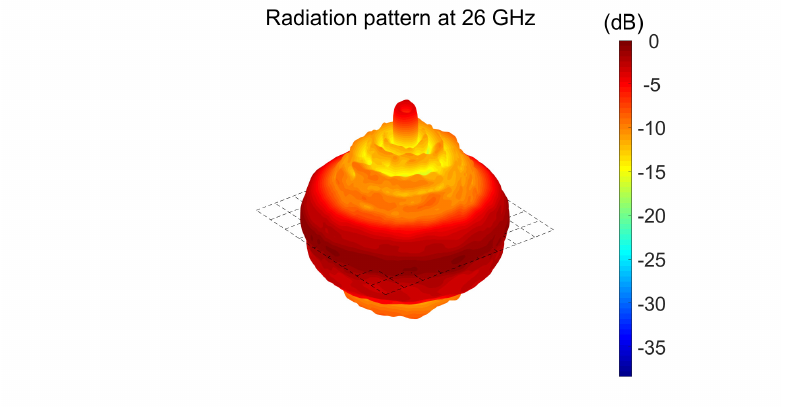
Figure 2. 3D radiation pattern of the antenna at 26